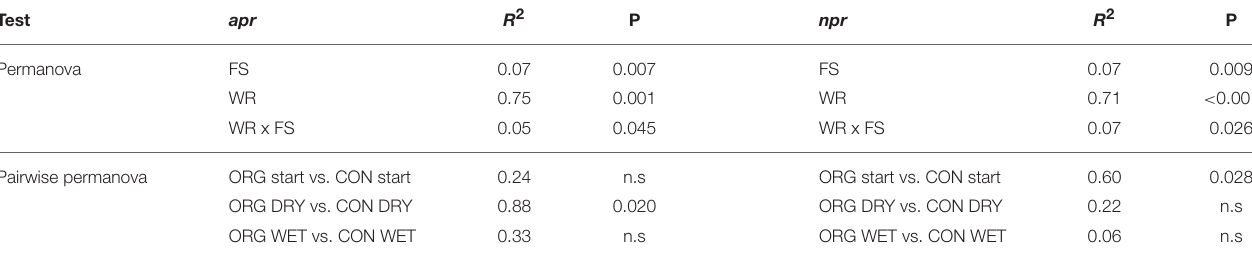
TABLE 3 | Effects of farming system (FS) and water regime (WR) on alkaline metallopeptidase ( apr ) and neutral metallopeptidase ( npr ) encoding microbial community structure. Test